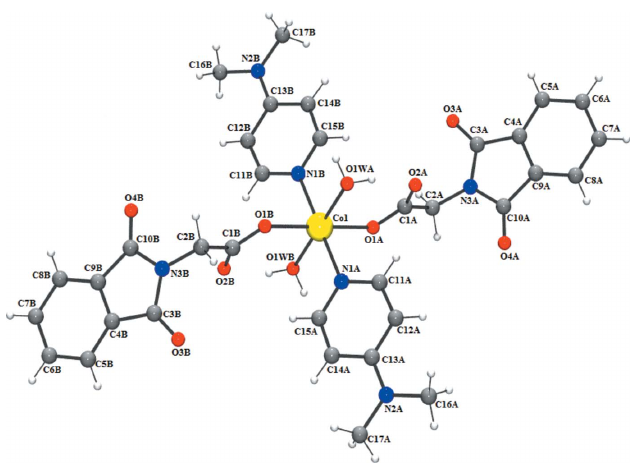
Figure 1 The molecular structure of the title compound with displacement spheres drawn at the 30% probability level. H atoms are shown as spheres of arbitrary